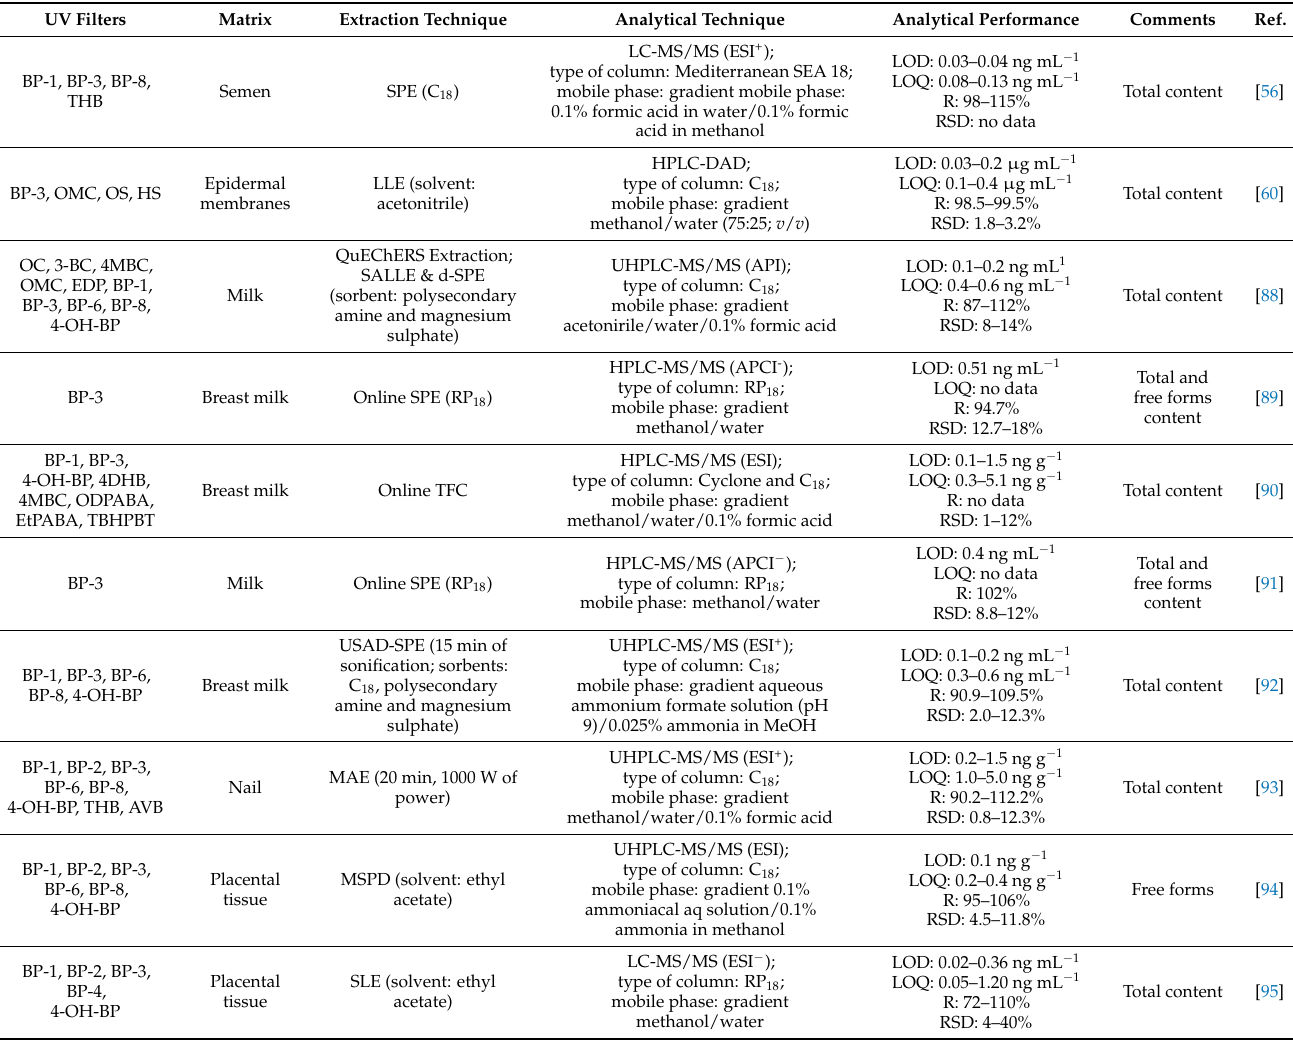
Table 5. Published studies on UV filters determination in semen, saliva, milk, nail, and placental tissue. UV